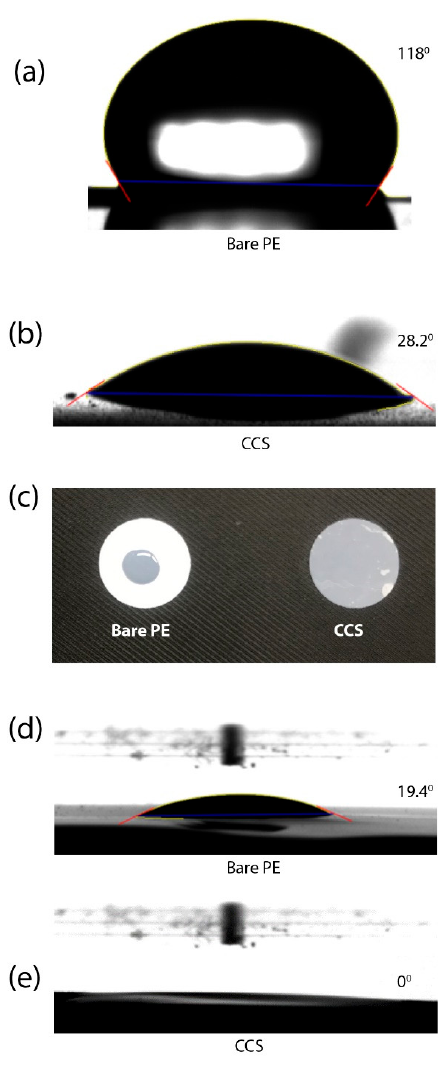
Figure 5. Contact angles images of ( a ) bare PE and ( b ) CCS after dropping droplets of DI water. ( c ) Digital camera images showing the wettability of separators with liquid electrolytes. Contact angle images of ( d ) bare PE and ( e ) CCS after dropping droplets of liquid electrolyte.